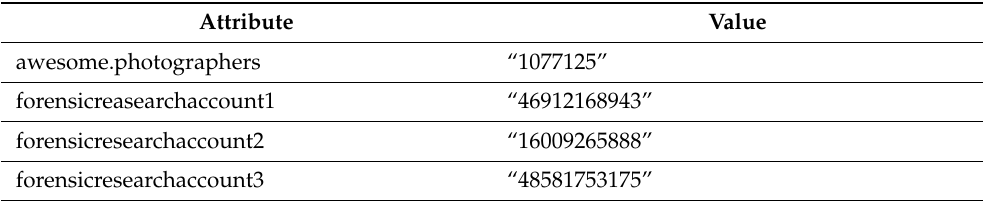
Table 10. Artifacts Found in users.usernameToId Record.